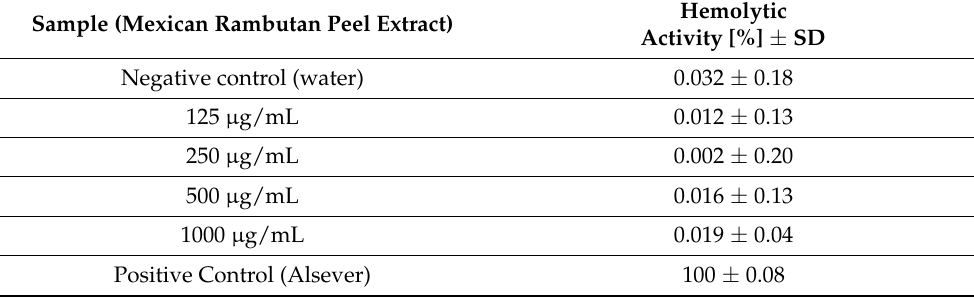
Table 4. Hemolytic activity of the polyphenolic extract in isolated human